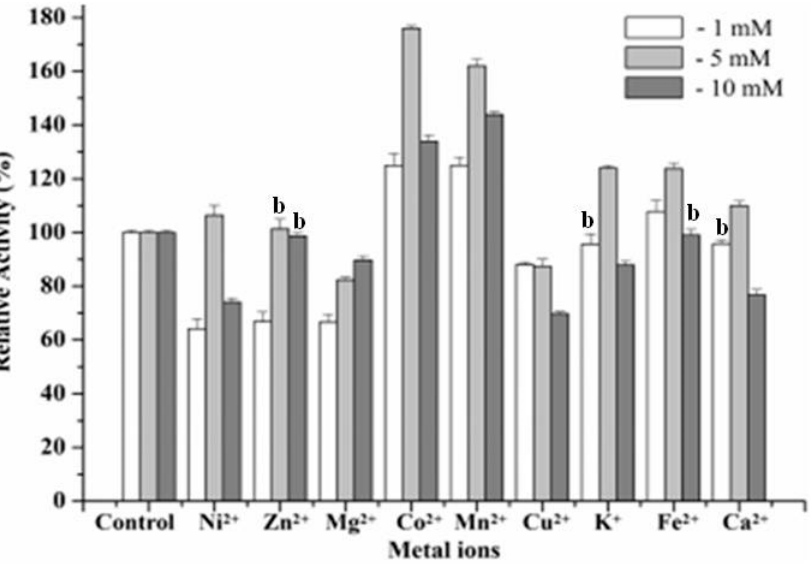
Figure 7. Action of metal cations on enzyme activity. b No significant difference between the group and the control group.